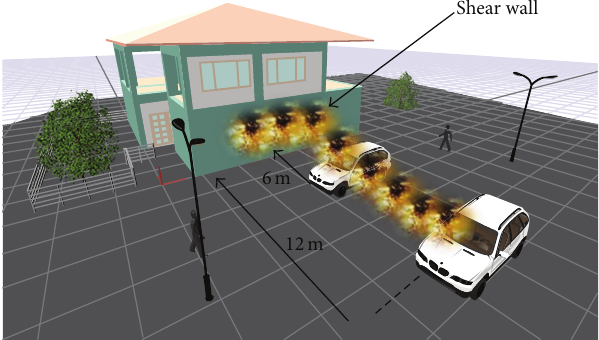
Figure 6: Modelled reinforced concrete building.